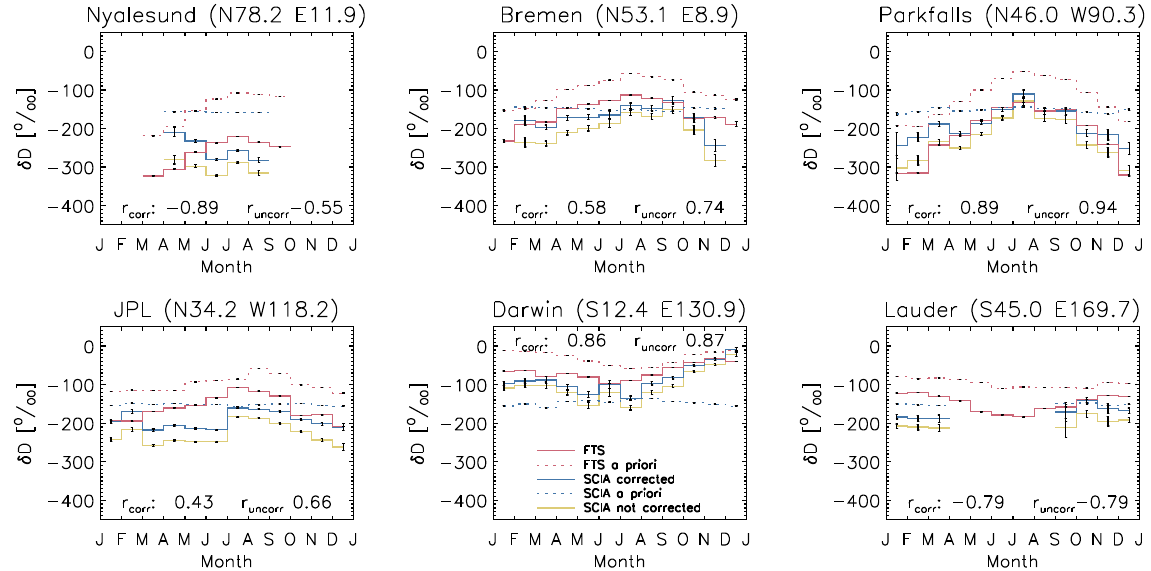
Figure 8. Monthly means for the TCCON stations. FTS data within ± 2h of the mean SCIAMACHY overpass time were used from all available years. SCIAMACHY data are for 2003–2007. Error bars denote standard errors of the mean. r corr and r uncorr refer to the correlation coefficients between the FTS data and respectively the offset-corrected and uncorrected SCIAMACHY data.